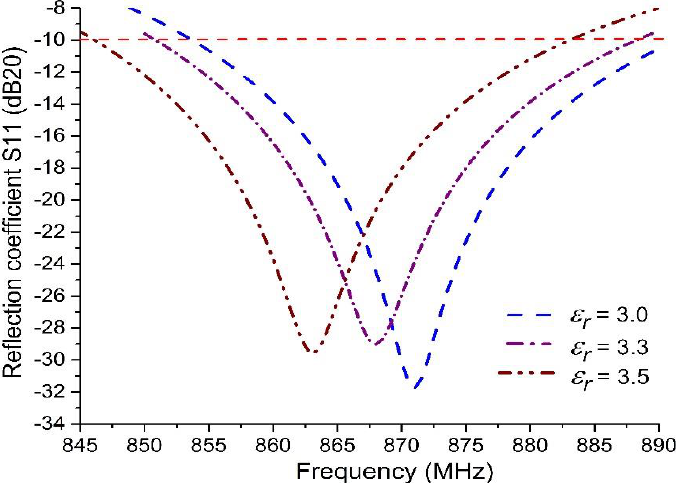
Figure 9. Reflection coefficient results w.r.t. dielectric change (ε r ) due to humidity-altering effect.